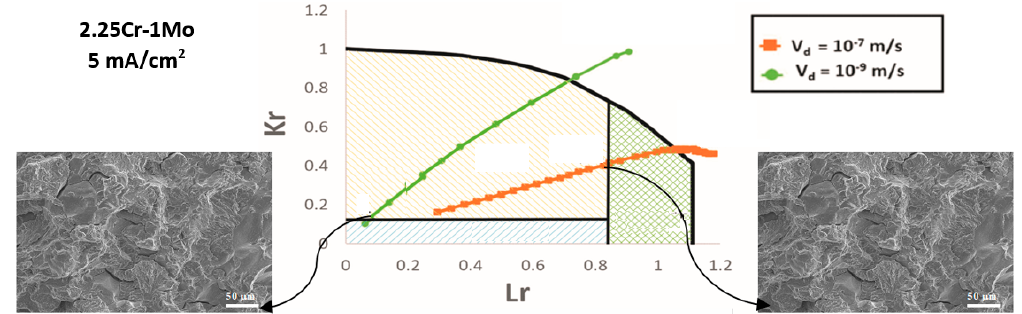
Figure 18. Crack path propagation displayed on the FAD, and fractography, from the slow rate tests performed on 2.25Cr-1Mo steel under 5 mA/cm 2 CC environment at 10 − 7 and 10 − 9 m/s.